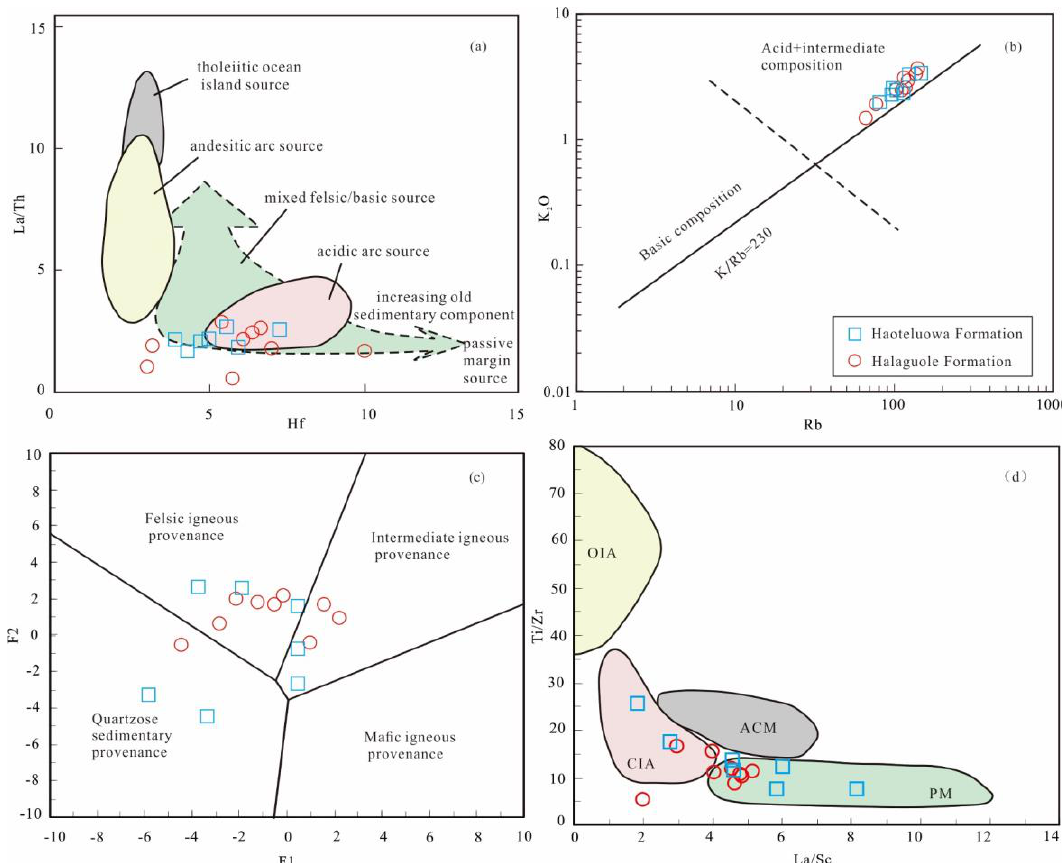
Figure 8. Geochemical diagrams showing variations in source composition and tectonic setting discrimination for the Carboniferous sandstones in Alake Lake, EKO. ( a ) La/Th–Hf diagram (after Floyd et al. [65]); ( b ) K 2 O–Rb diagram (after Floyd et al. [65]); ( c ) F1–F2 diagram (after Roser et al. [66]); ( d ) Ti/Zr–La/Sc (after Bhatia and Crook [67]). F1 = − 1.773TiO 2 + 0.607Al 2 O 3 + 0.76 Fe 2 O 3T − 1.5MgO + 0.616CaO + 0.509Na 2 O − 1.224 K 2 O − 9.09. F2 = 0.445TiO 2 + 0.07Al 2 O 3 − 0.25 Fe 2 O 3T −